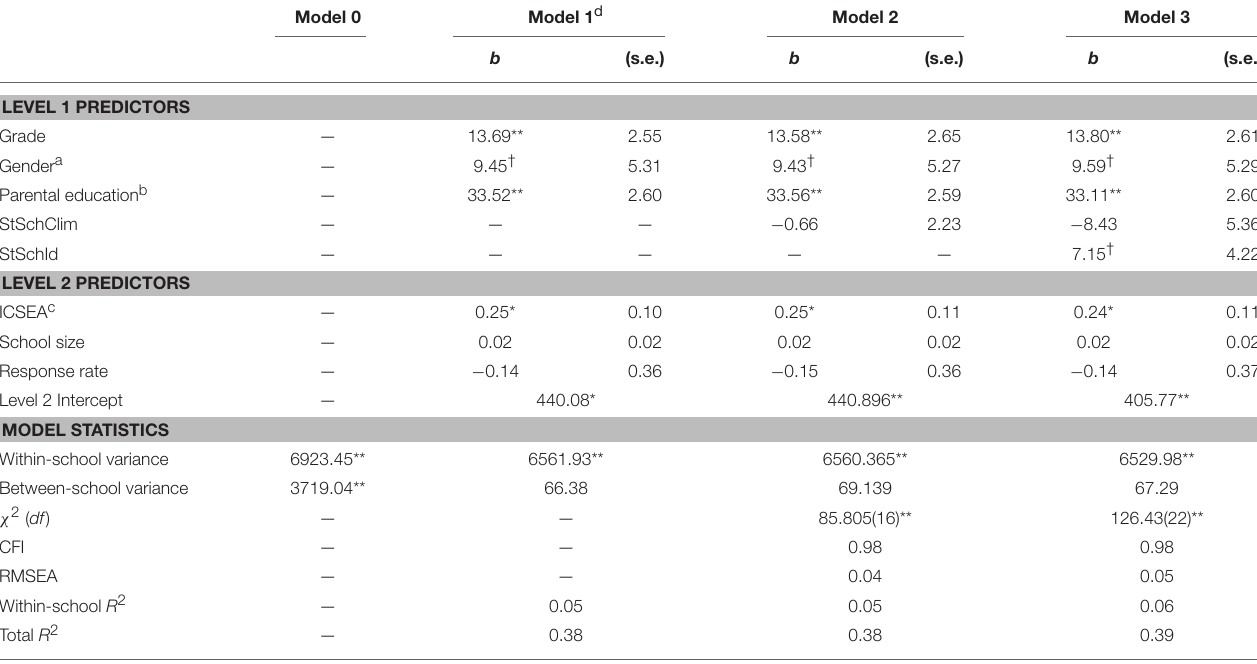
TABLE 5 | Multilevel SEM results for models 0–3 explaining NAPLAN